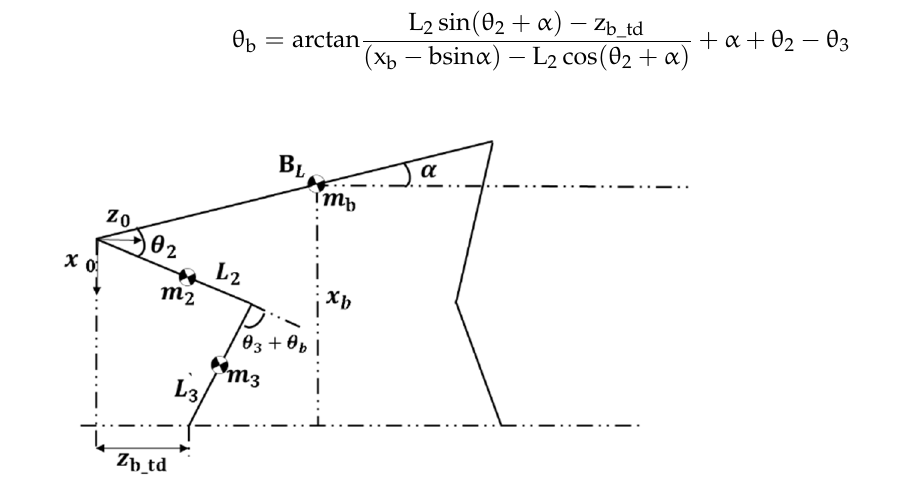
Figure 7. Pose diagram of quadruped robot.